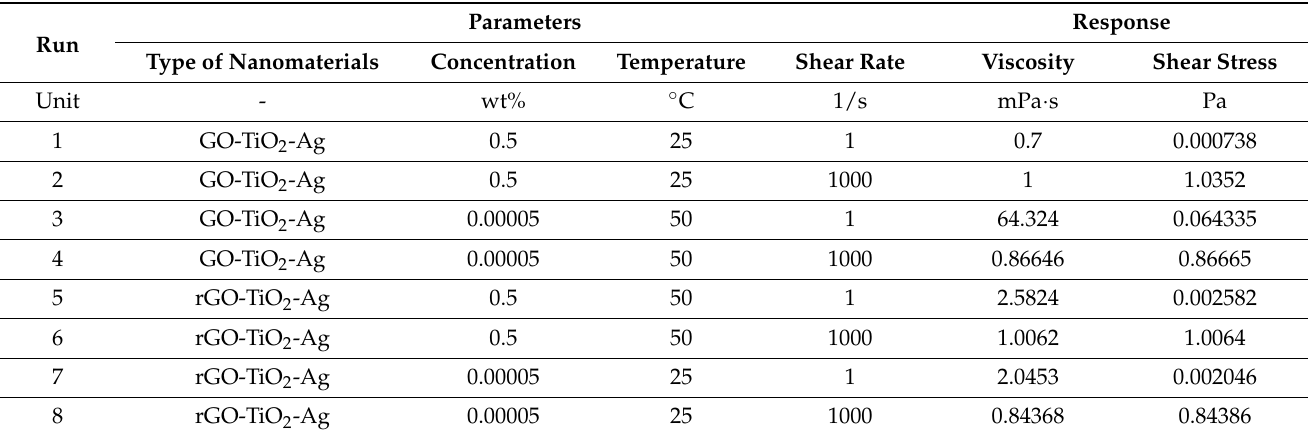
Table 2. Orthogonal Array P-4 and